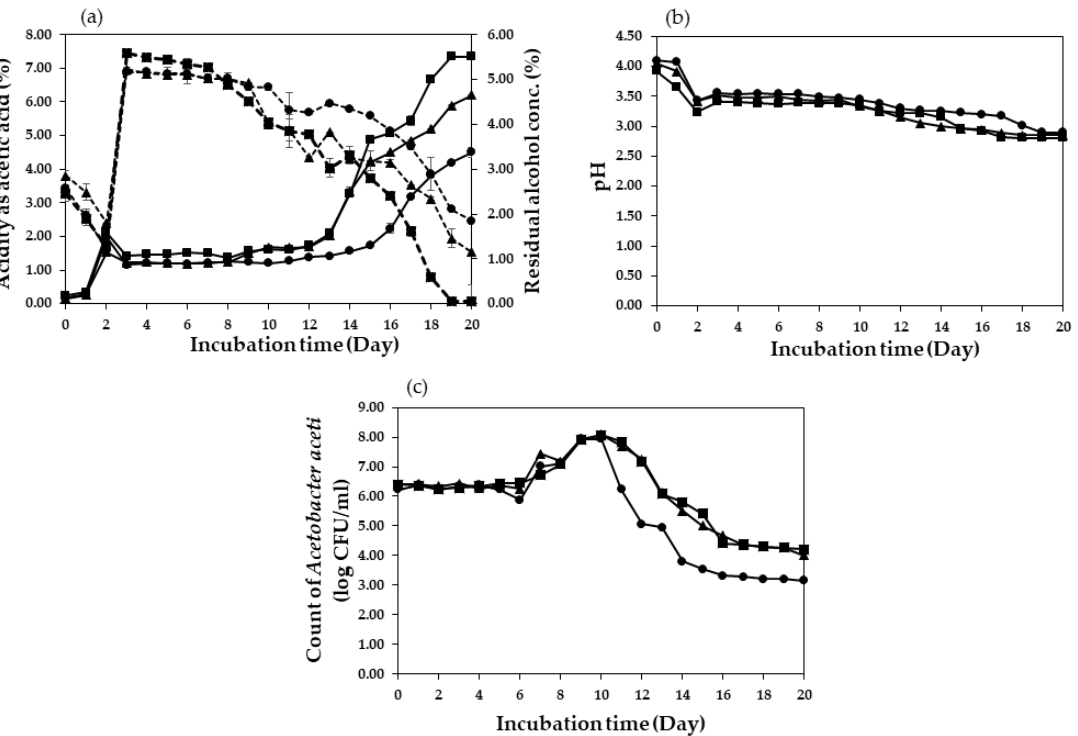
Figure 3. The change in acetic acid (solid line) and residual alcohol (dash line) concentrations ( a ), the pH values ( b ), and bacterial population ( c ) of pineapple vinegar ( (cid:4) ), pineapple vinegar mixed with dragon fruit without peel ( (cid:78) ), and pineapple vinegar mixed with dragon fruit with peel ( • ) during vinegar fermentation by A. aceti TISTR 354.